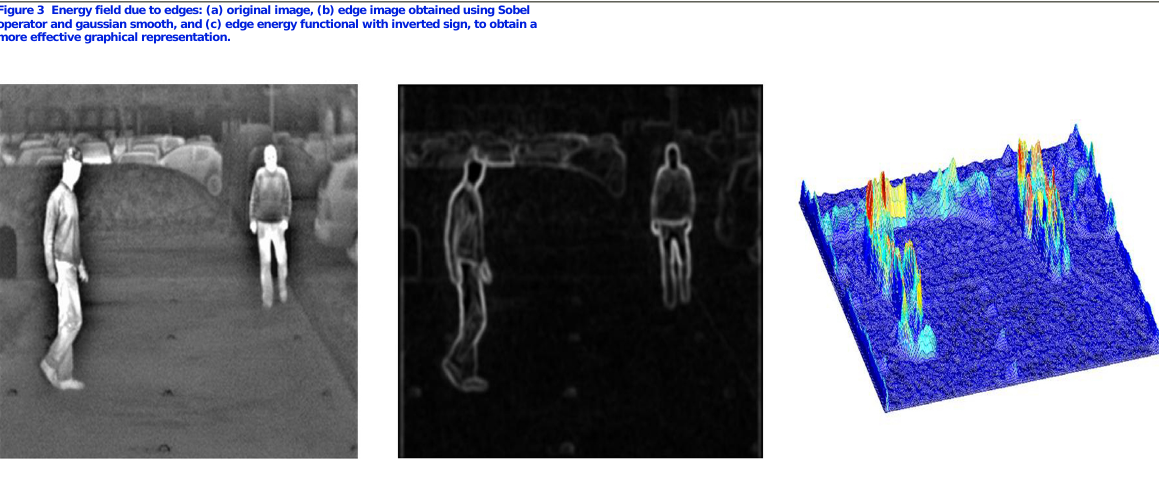
Figure 3 Energy field due to edges: (a) original image, (b) edge image obtained using Sobel operator and gaussian smooth, and (c) edge energy functional with inverted sign, to obtain a more effective graphical representation.